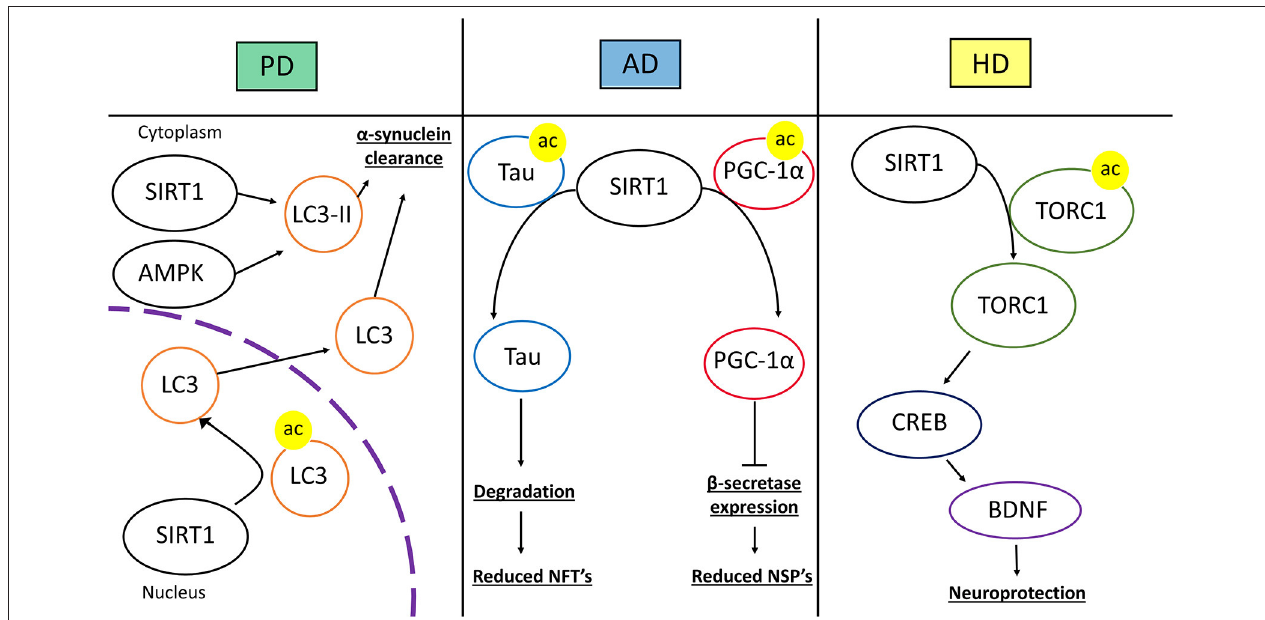
FIGURE 7 | Therapeutic mechanisms of SIRT1 in neurodegenerative disease. The left panel represents SIRT1 in Parkinson’s disease (PD). SIRT1 deacetylates microtubule-associated protein 1A/1B-light chain 3 (LC3) in the nucleus which induces the translocation of LC3 into the cytoplasm. In the cytoplasm, SIRT1 and AMP-activated Protein Kinase (AMPK) coordinate to activate LC3-phosphatidylethanolamine (LC3-II). These mechanisms lead to increased autophagic clearance of α -synuclein, reducing α -synuclein deposits. In the middle panel, SIRT1’s role in Alzheimer’s disease (AD) is represented. SIRT1 can directly deacetylate acetylated-tau protein, increasing its susceptibility to degradation and prevent tau from forming neurofibrillary tangles. SIRT1 can also deacetylate peroxisome proliferator-activated receptor γ (PPAR γ ) coactivator-1 α (PGC-1 α ), which increases its transcriptional regulation activity. After being deacetylated, PGC-1 α can instill transcriptional repression of β -secretase, which in turn can reduce the level of amyloid- β production and neuritic senile plaque accumulation. The right panel represents Huntington’s disease (HD). SIRT1 deacetylates CREB-regulated transcription coactivator 1 (TORC1), which allows TORC1 to activate cAMP response element-binding protein (CREB). CREB then transcriptionally upregulates brain-derived neurotrophic factor (BDNF). The increase in BDNF promotes neurotrophic and neuroprotective mechanisms against HD